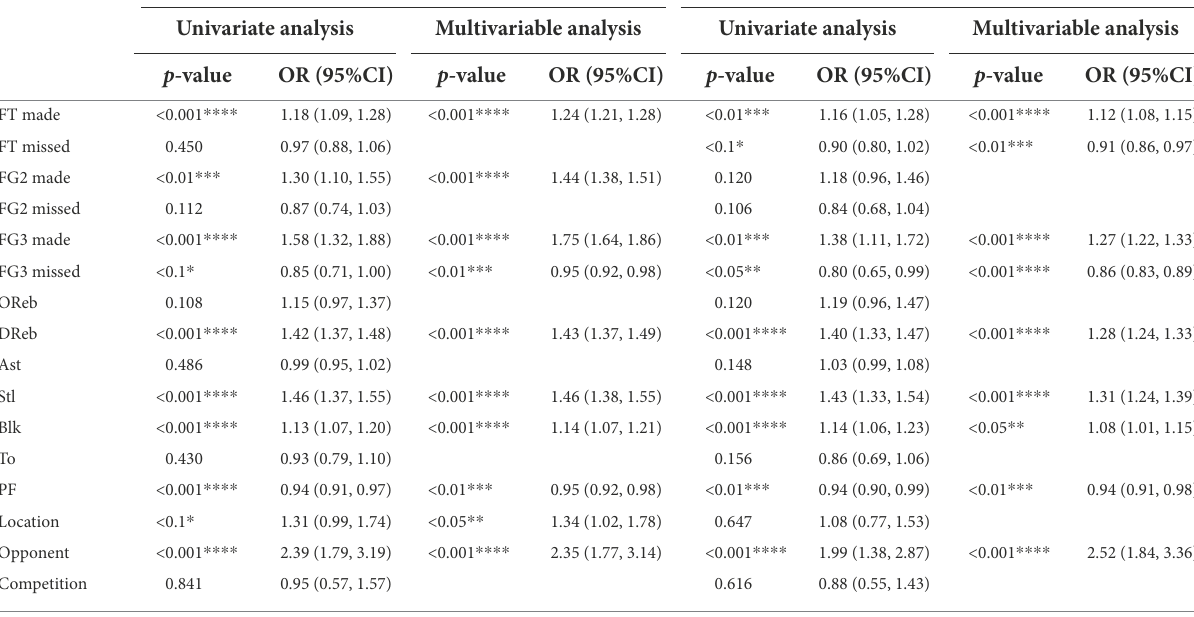
TABLE 2 Results relating to the logistic regression models run (dependent variable is “match outcome = WIN”). Before COVID-19 (with spectators) AFTER (without